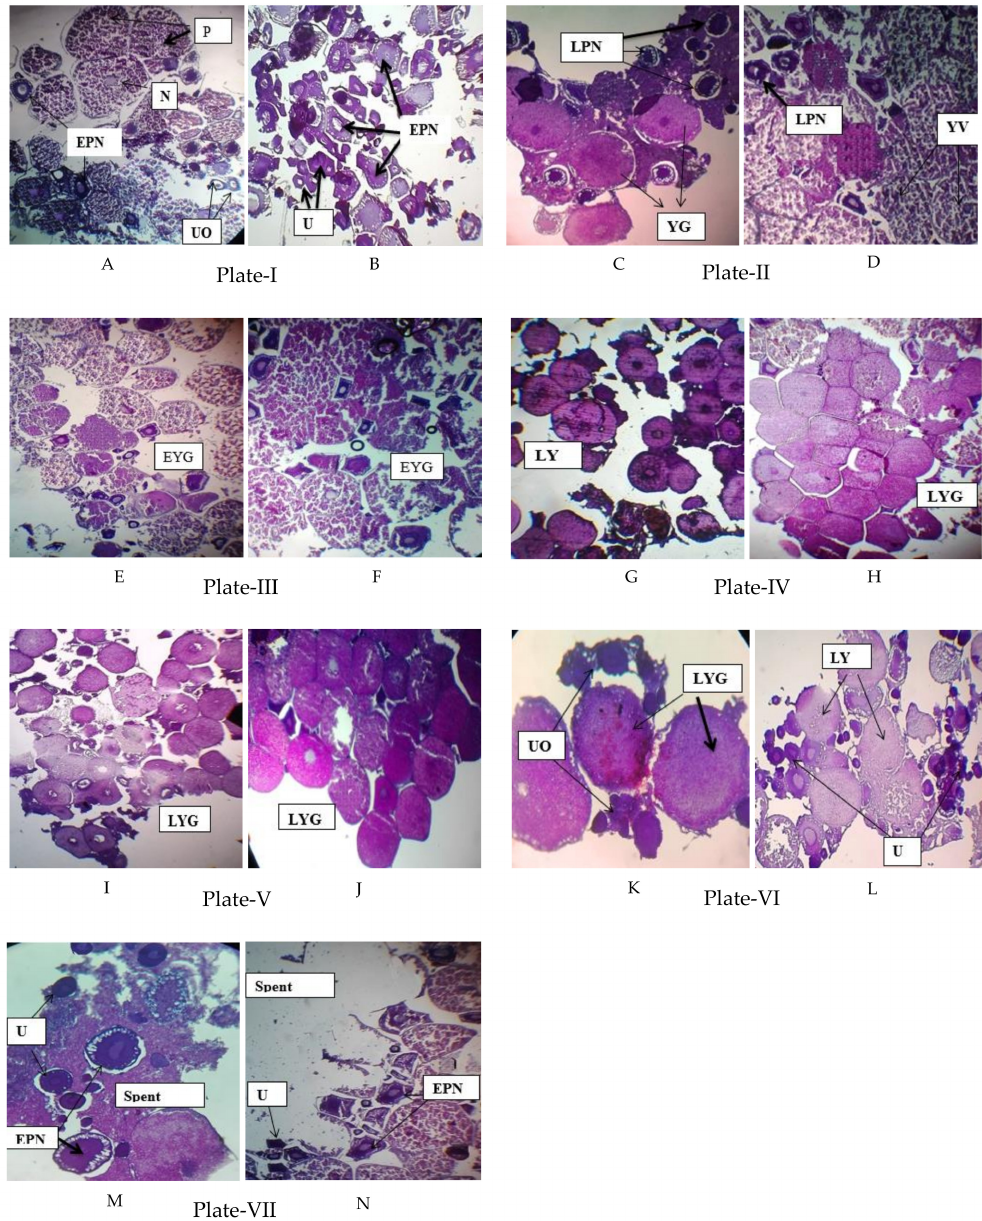
Figure 2. Histology of ovary of P. sophore . Plate I: Early perinucleolar stage of oocytes (EPNO), Nucleus with nucleoli (N), Undeveloped oocyte (UO), Premature stage (PM) in March in Gazipur ( A ) and Jessore ( B ). Plate II: Late perinucleolar stage of oocytes (LPNO), Yolk vesicle stage of oocytes (YVO) and Yolk granule stage of oocytes (YGO) in April in Gazipur ( C ) and Jessore ( D ). Plate III: Early Yolk-granule stage of oocytes (EYGO) in May in Gazipur ( E ) and Jessore ( F ). Plate IV: Late Yolk-granule stage of oocytes (LYGO) in June in Gazipur ( G ) and Jessore ( H ). Plate V: LYGO in July in Gazipur ( I ) and Jessore ( J ). Plate VI: LYGO and UO in August in Gazipur ( K ) and L Jessore ( L ). Plate VII: Spent phase, EPNO and UO in September in Gazipur ( M ) and Jessore ( N ). Hematoxylin & Eosin stain ×